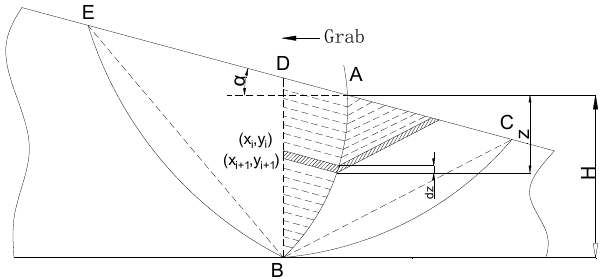
Figure 6. Partition diagram of material unit body.